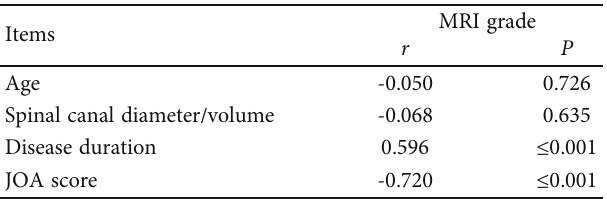
Table 4: Correlation analysis of MRI grade and information of